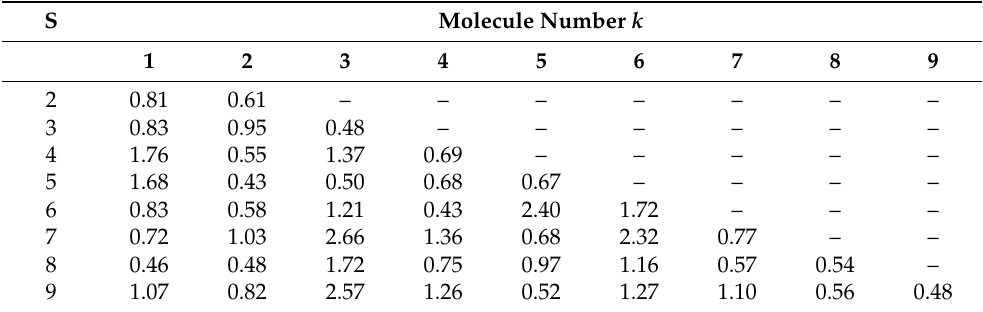
Table 1. The maximum number of revolutions in one direction (2 π -rotation).